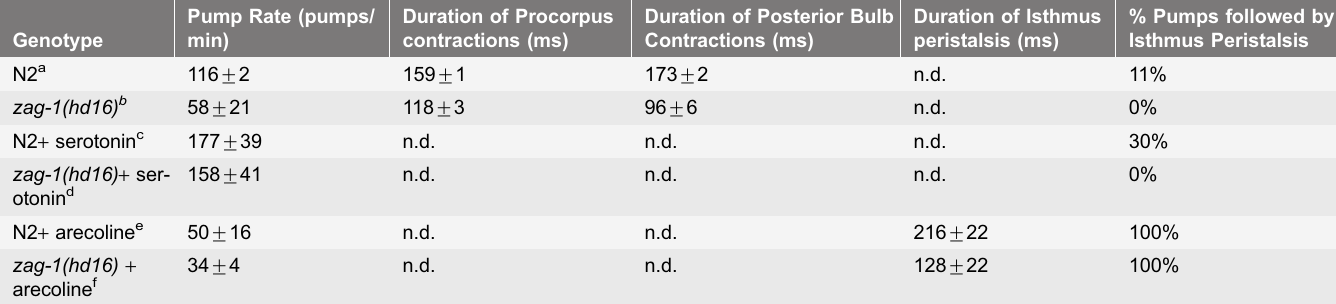
Table 2. Summary of feeding behavior in wild-type and zag-1 mutants. Genotype